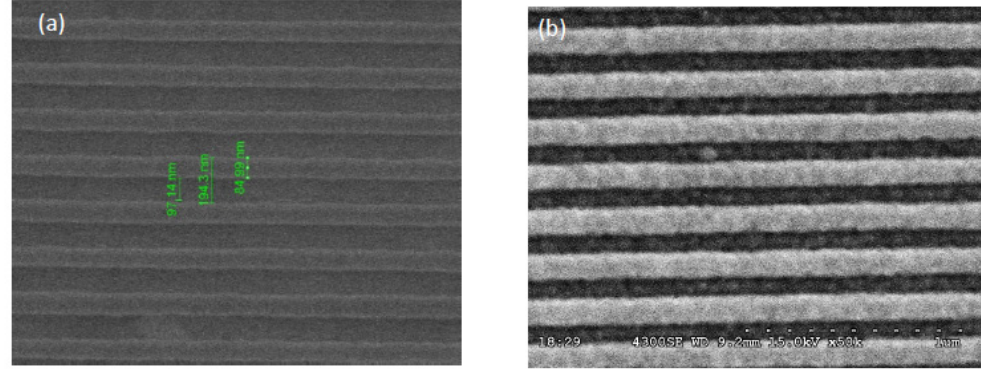
Figure 23. SEM images of the fabricated samples: ( a ) 200 nm-period PMMA nanograting; ( b ) Gold thin film coated 200 nm-period nanograting. Reprinted with permission of [86].